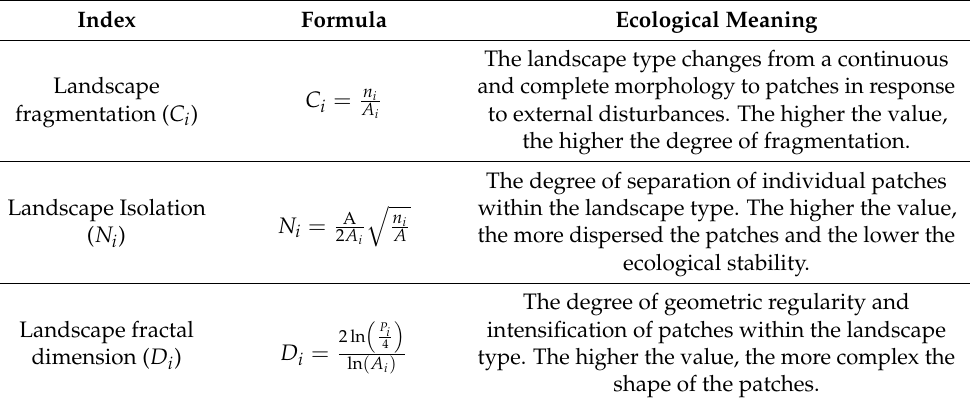
Table 1. Ecological meaning and expression of the landscape index.